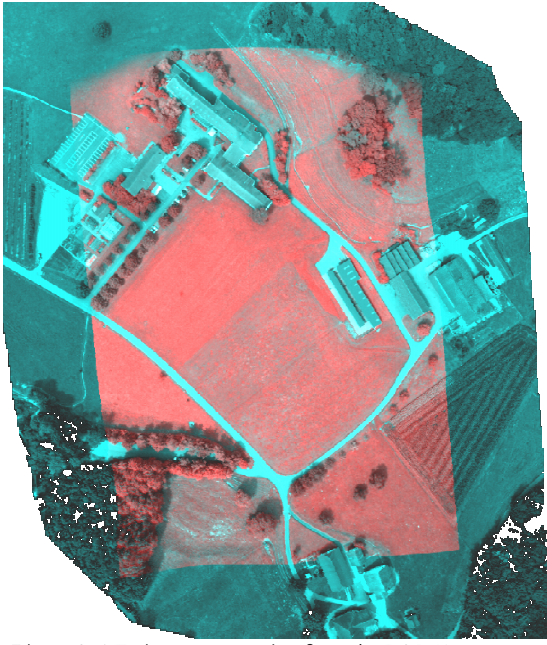
Figure 6: CIR image generation from the RGB Master camera and the NIR Nikon images after co - - registration.